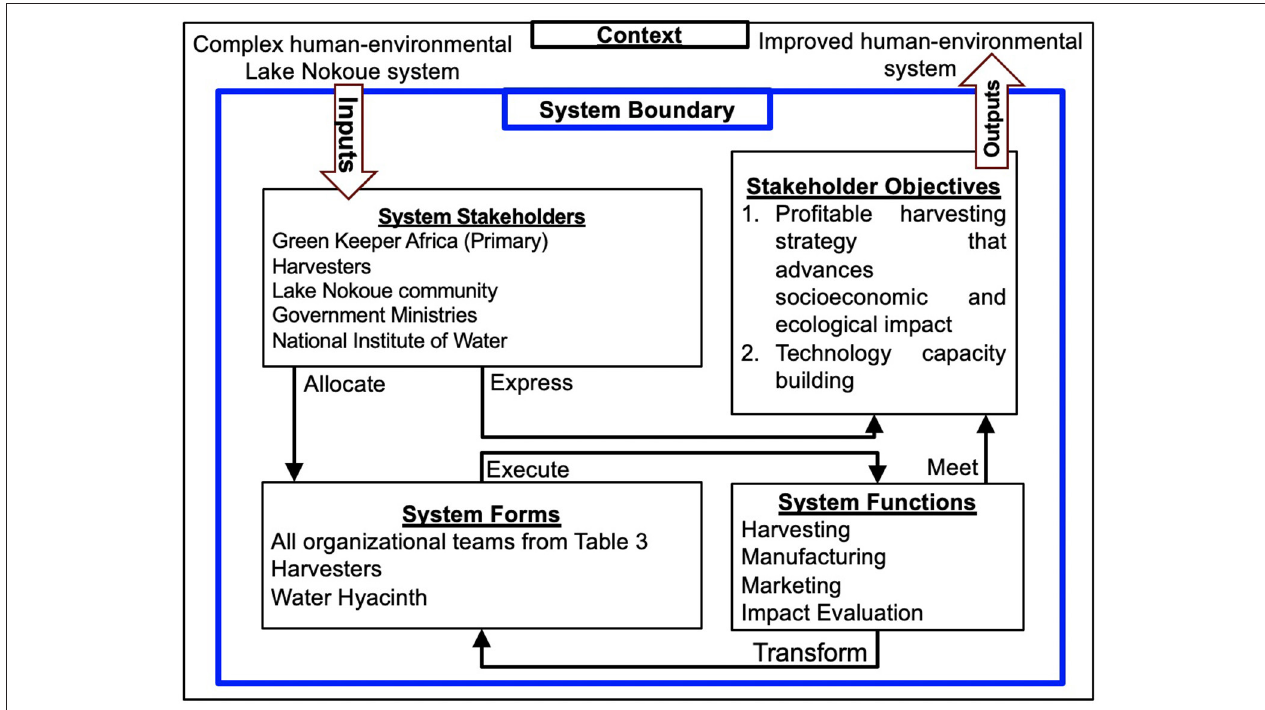
FIGURE 6 | Summary of the system Stakeholders, Forms, Functions and Desired Outcomes (from the perspective of GKA). GKA allocates forms which execute functions that meet their objectives. Credit: The Authors.